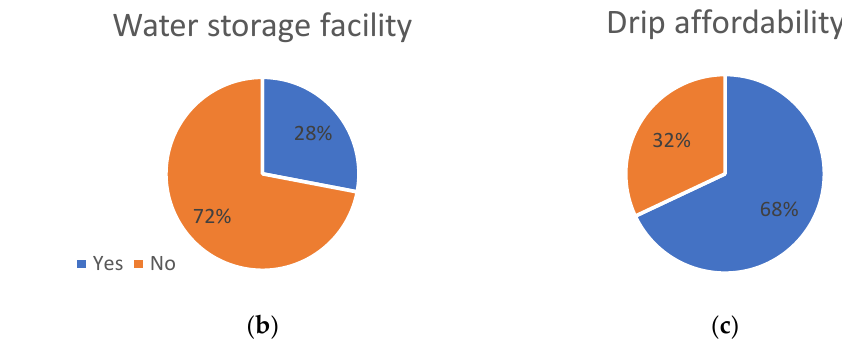
Figure 6. Respondent perceptions on ( a ) awareness about soil moisture sensors, ( b ) awareness about on-farm water storage facilities, and ( c ) affordability of the drip system by farmers receiving a 60% subsidy from the institutions.